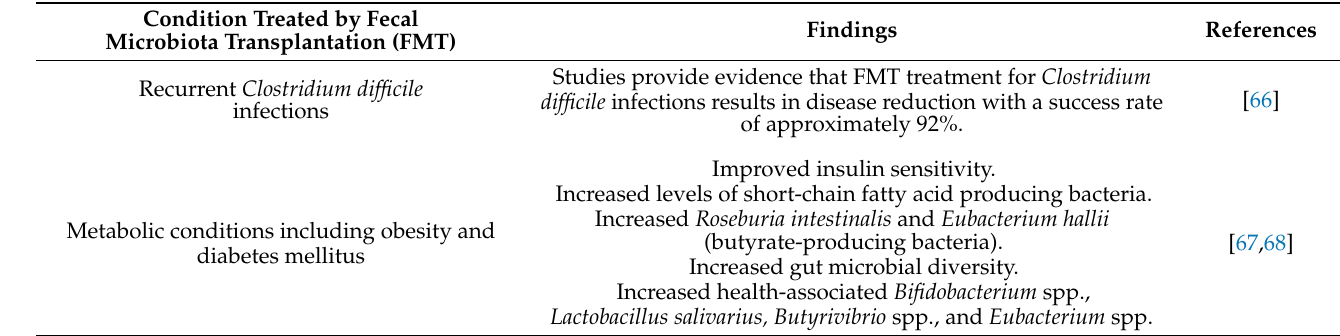
Table 4. Fecal microbiota transplantation (FMT) as a therapeutic strategy for reversal of microbial dysbiosis. Condition Treated by Fecal Microbiota Transplantation